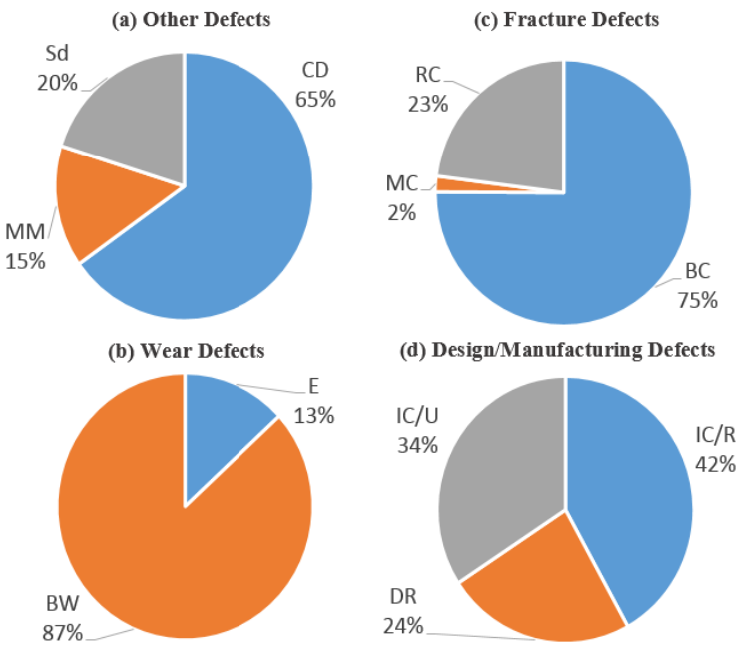
Figure 10. Breakdown of the most frequent defects in three years.